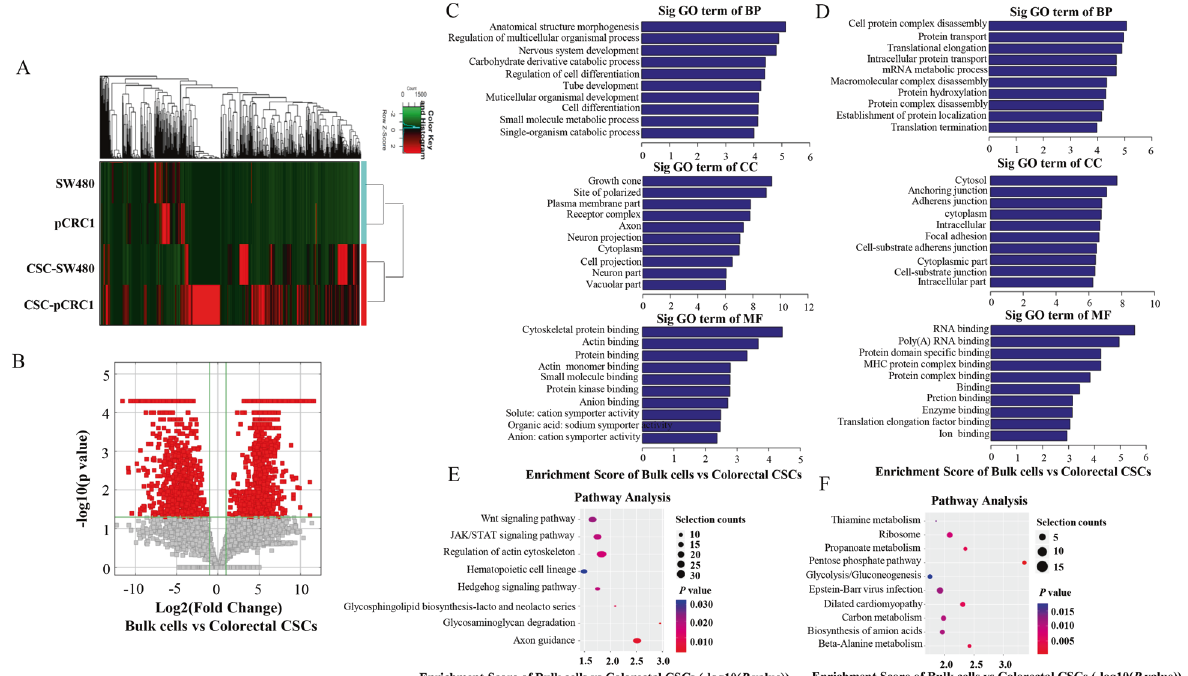
Fig. 3 RNA-sequence analysis of CRC cells and colorectal CSCs. ( A ) Heat map of 2718 differentially expressed genes between bulk cells and colorectal CSCs (SW480 and pCRC1 vs CSCs-SW480 and CSC-pCRC1). Each column represents one sample; each row represents one probe set. Red indicates upregulated expression, while green indicates downregulated expression. The image is one represent of three independent experiments. ( B ) A volcano plot was arranged using the fold change and P value. The red rectangle represents differentially expressed genes between bulk cells and colorectal CSCs, P < 0.05, fold change ≥ 2.0. The image is one represent of three independent experiments. ( C ) GO analysis of upregulated genes between bulk cells and colorectal CSCs. The data presented here are from one representative experiment of three independent experiments. ( D ) GO analysis of downregulated genes between bulk cells and colorectal CSCs. The data presented here are from one representative experiment of three independent experiments. ( E ) KEGG pathway analysis of upregulated genes between bulk cells and colorectal CSCs. The data presented here are from one representative experiment of three independent experiments. ( F ) KEGG pathway analysis of downregulated genes between bulk cells and colorectal CSCs. The data presented here are from one representative experiment of three independent